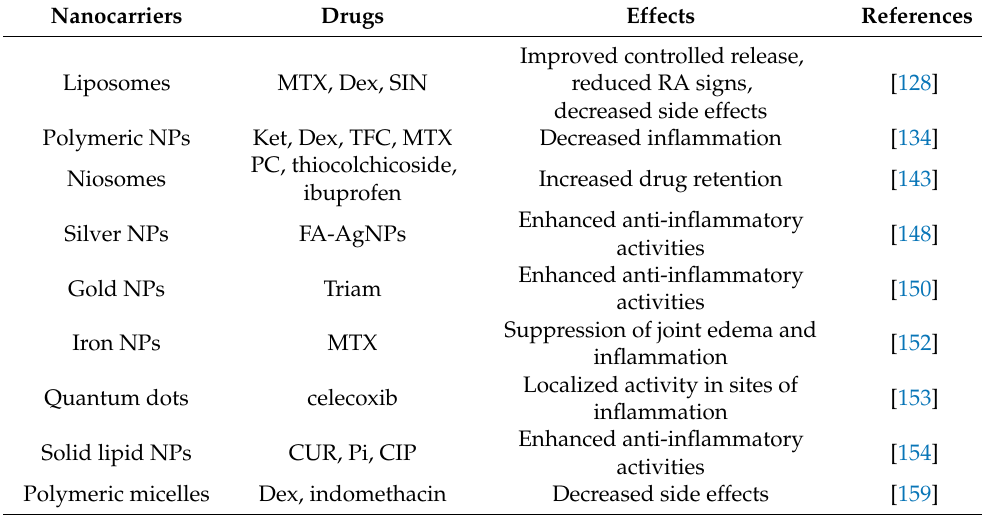
Table 1. Various nanostructures as a novel platform in improving function of anti-RA